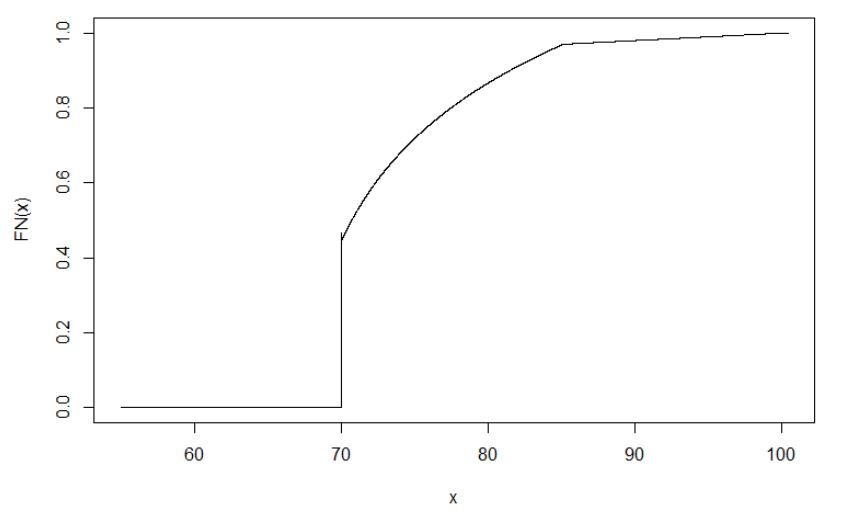
Figure 11. Bid distribution function assuming bid function f N , source: own figure. Using this bid distribution the probability of winning and the optimal bids for all valuations can be derived like before. The optimal bid function—assuming the bidding strategy f N for other participants—is presented in Figure 12. The graph illustrates that the assumed bid function is correct. The assumed and optimal bids for all 10,000 valuations are presented in Figure 13.